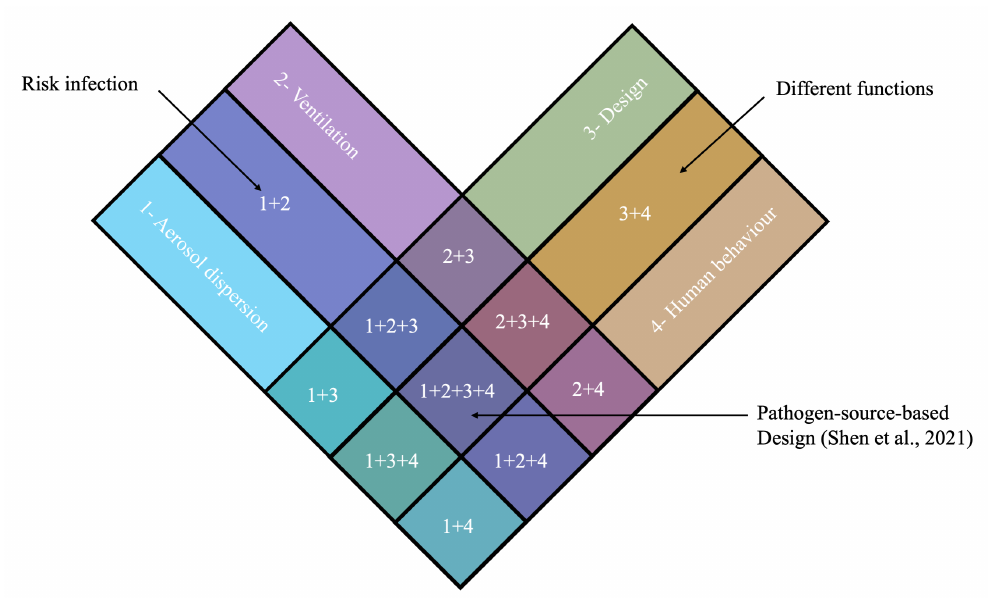
Figure 5. The interdependence between the design and human behavior disciplines and the engi- neering fields that deal with aerosol dispersion and ventilation. The term "Pathogen-source-based Design" was found in Shen et al.